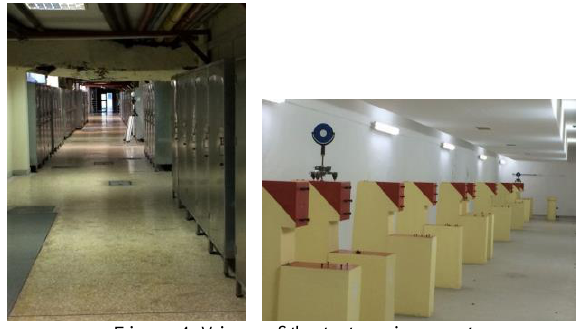
Figure 4. Views of the test environment